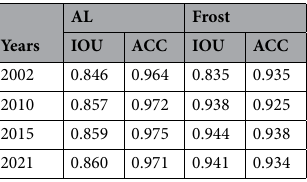
Table 6. Results of accuracy assessment for AL classification and frost-affected areas using IOU and ACC